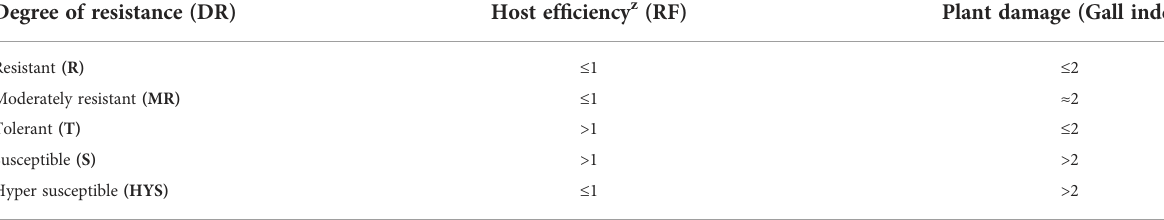
TABLE 2 Adapted quantitative scheme for assignment of Canto-Saenz ’ s (AQSCS) host suitability (resistance) designations. Degree of resistance